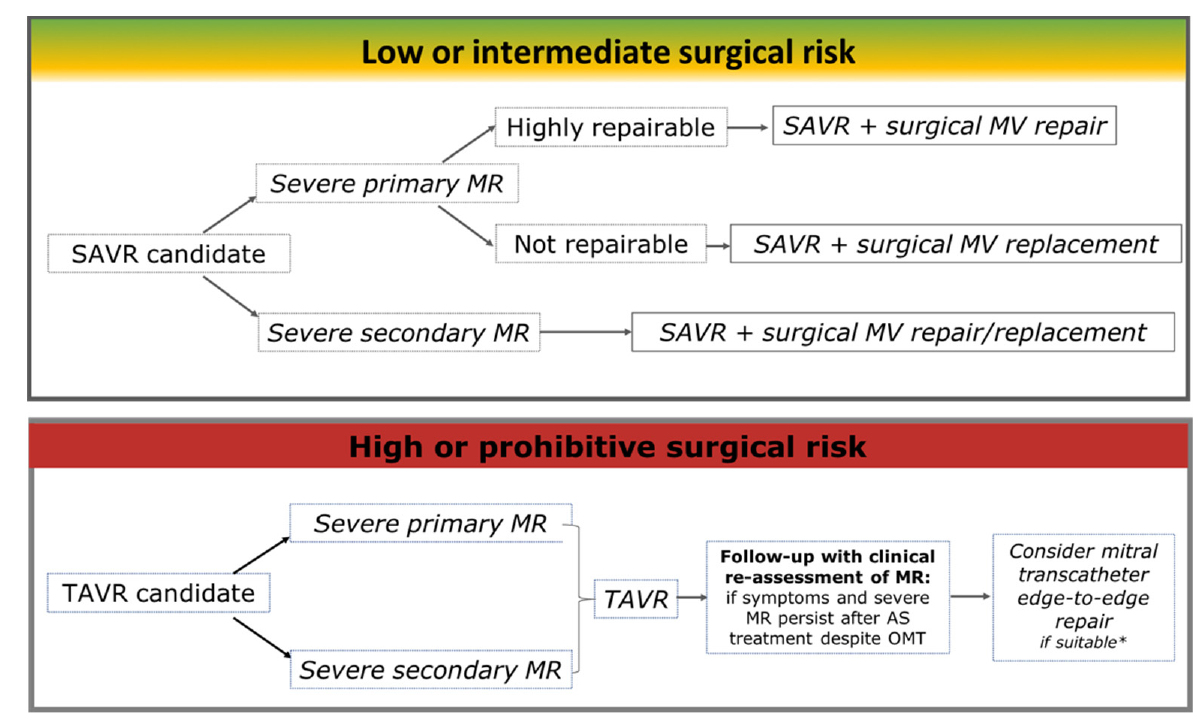
Figure 4. Management of patients with aortic valve stenosis and mitral regurgitation according to surgical risk.* Unsuitability for transcathether edge-to-edge mitral repair due to: (a) Severe mitral annular calcification with mitral stenosis or calcium extension into the leaflets, or restricted leaflet motion; (b) Severely calcified or fibrotic leaflet(s) (potential for mitral stenosis); (c) Prohibitively small mitral valve area (MVA < 3.5 cm 2 ); (d) Severe mitral valve complexity (i.e., extensive Barlow’s disease with multiple jets; (e) excessive redundancy, calcifications, or scarcity of coaptation reserve in the leaflets; MR is primarily due to clefts); (f) Short or restricted posterior mitral leaflet (<5 mm in the intended grasping location). SAVR: surgical aortic valve replacement; MR: mitral regurgitation; MV: mitral valve; TAVR: transcatheter aortic valve replacement; AS: aortic stenosis; OMT: optimal